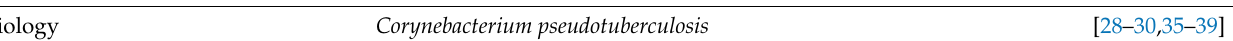
Table 2. Clinical antemortem signs and gross lesions were observed post-mortem on small ruminants with chronic wasting caused by infectious diseases. Caseous Lymphadenitis (CLA) or